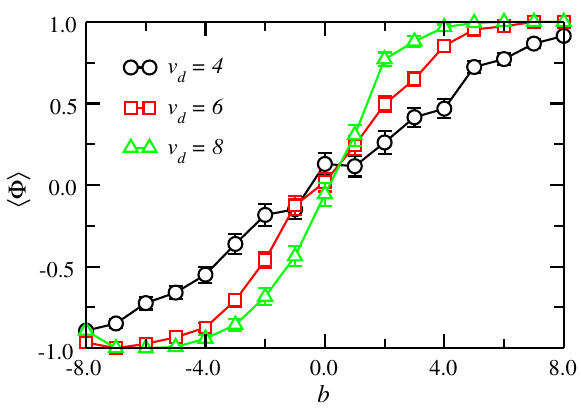
FIG. 2. Average order parameter h Φ i as a function of the asymmetry parameter b , for three different values of the drift velocity. We see that order is only induced for j b j > 0 . The slower v , the higher j b j should be in order to achieve a two-lane pattern. d The remaining parameters, including the lack of noise, are the same as in Fig.